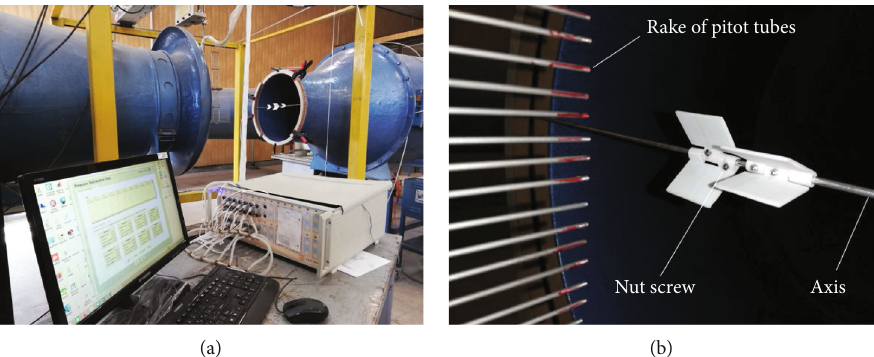
Figure 5: (a) Test section, traverse mechanism, and model located on the ring-shaped stand. (b) The rake of Pt probes and splitting airfoils arrangement (close-up).